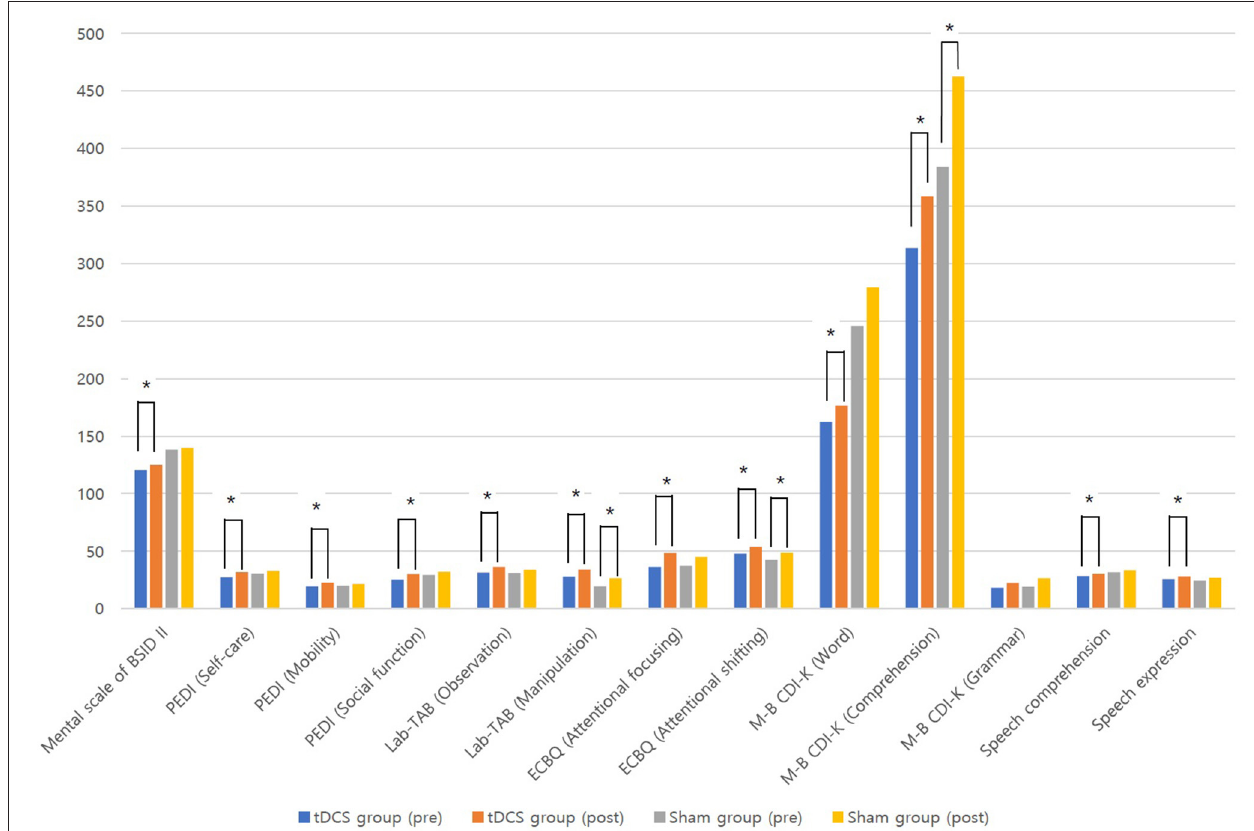
FIGURE 2 | Comparisons of outcomes before and after treatment in tDCS and sham groups. * p < 0.05 by Wilcoxon signed-rank tes.